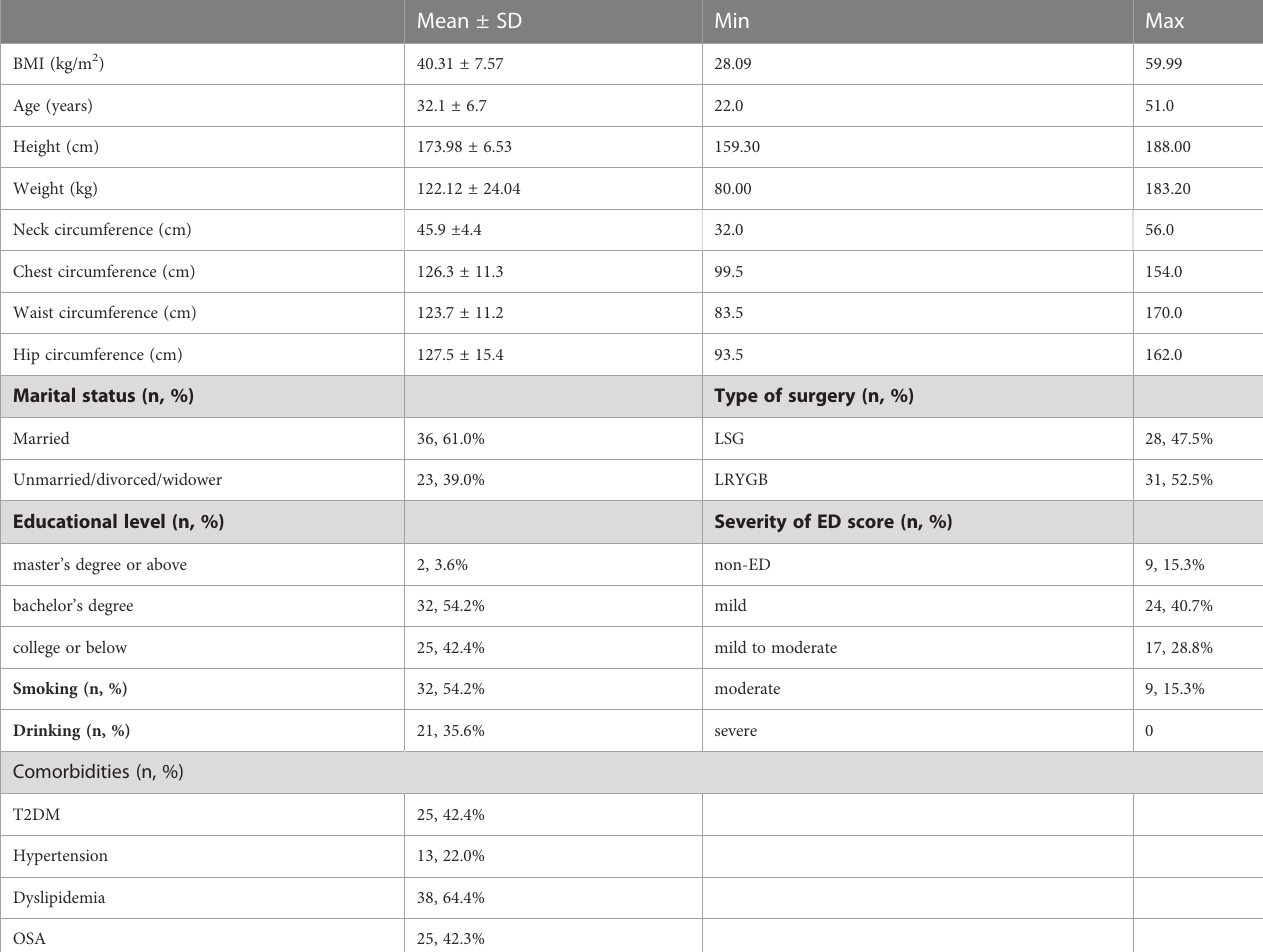
TABLE 1 Demographic data of patients (n =